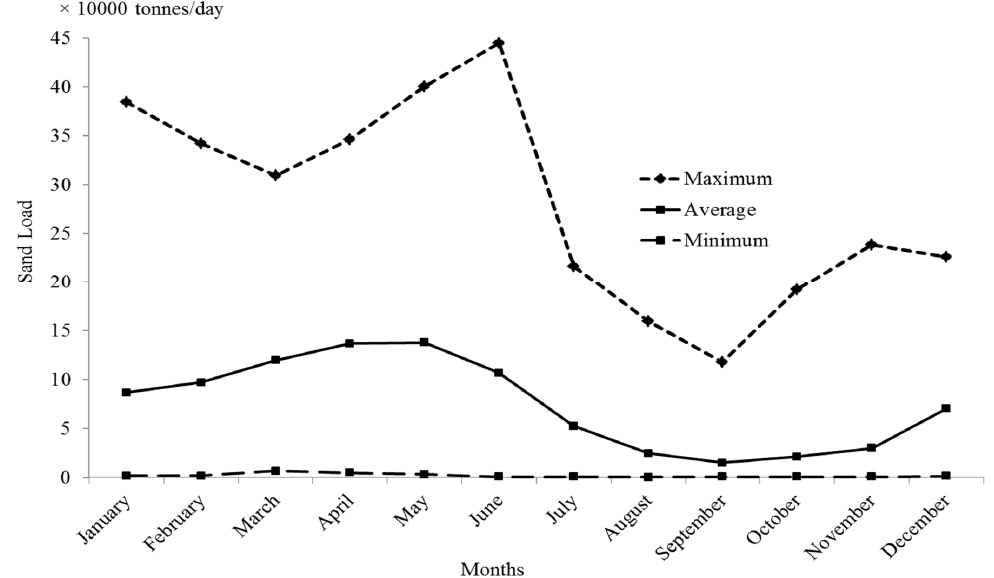
Figure 12. Seasonal trend of monthly mean, maximum, and minimum of daily sand load at Tarbert Landing of the LmMR during 1973–2013. Table 4. Sand transport under five river stages at Tarbert Landing of the LmMR from 1973 to 2013.